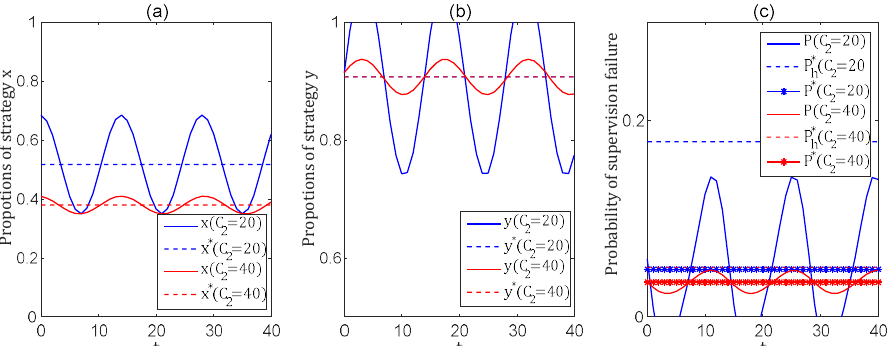
Figure 5. The influence of legal production cost C 2 on the periodical fluctuation. ( a ) The periodical fluctuation in the proportions of strategies x with different legal production costs C 2 = 20 and C 2 = 40. ( b ) The periodical fluctuation in proportions of strategies y with different legal production costs C 2 = 20 and C 2 = 40. ( c ) The periodical fluctuation in the probability of supervision failure P with different legal production costs C 2 = 20 and C 2 = 40.